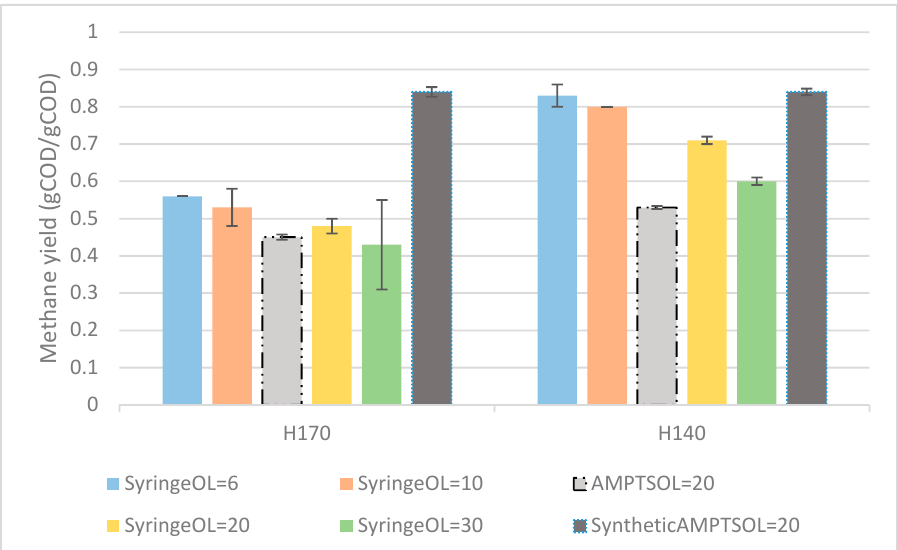
Figure 3. Methane yield of H140 under thermophilic condition under different OLs.